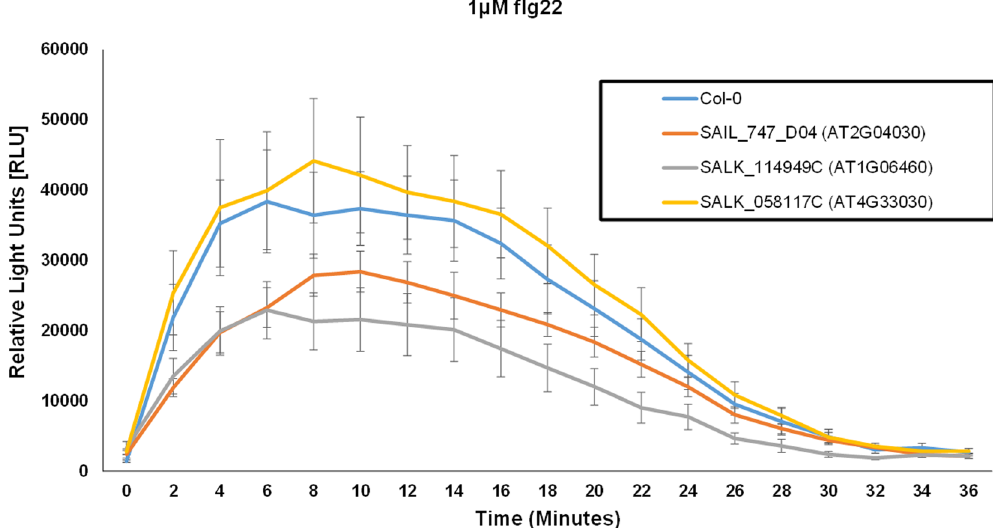
Figure 5. Reactive oxygen species (ROS) burst in Arabidopsis leaves triggered by flg22. ROS profile of Col- 0, SAIL_747_D04 (AT2G04030), SALK_114949 C (AT1G06460) and SALK_058117 C (AT4G33030) at the indicated time points are shown. Leaf samples were harvested from four-week-old Arabidopsis plants and ROS burst was measured by a luminol-based assay immediately after addition of 1 μ M flg22. The data are shown as means ± SEs (standard error) from 8 leaf discs.